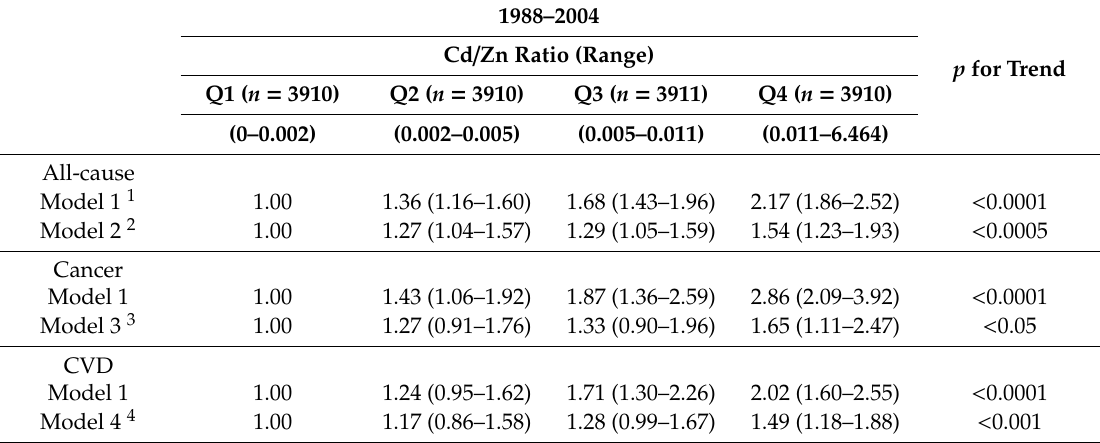
Table 5. Multivariable adjusted HR (95% CI) of all-cause, cancer and CVD mortality using Cox proportional hazards models among US adults ≥ 30 years old in NHANES 1988–2004 by quartile of Cd / Zn ratio ( n =